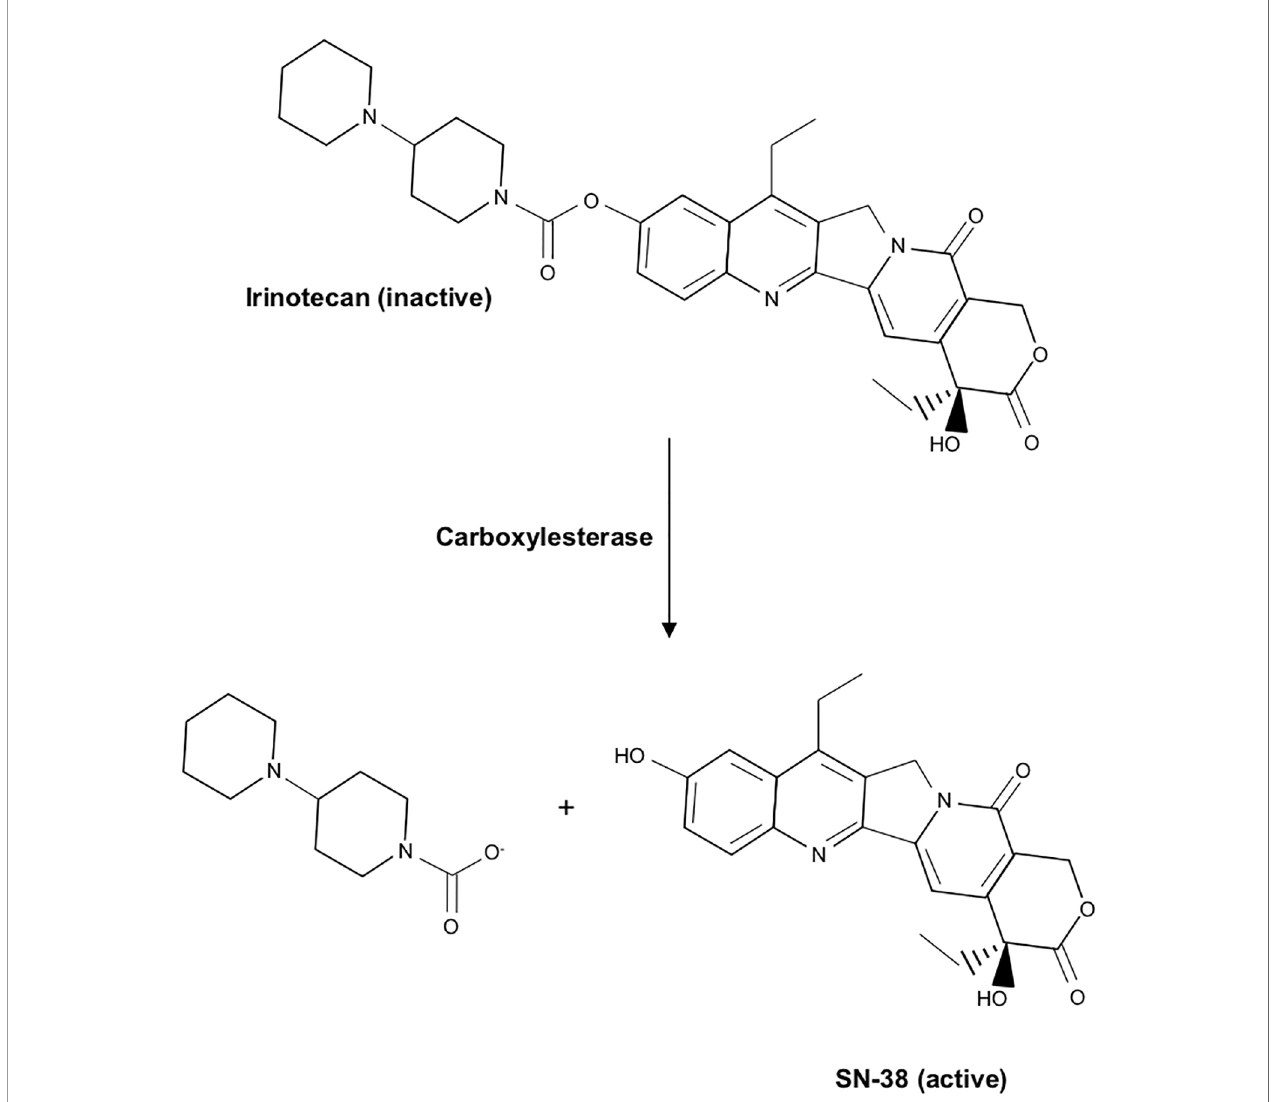
FIGURE 8 | Chemical structure of Irinotecan and conversion to its active metabolite SN-38. In the intestinal mucosa, liver, and plasma, Irinotecan undergoes carboxylesterase-mediated cleavage of the carbamate bond between the camptothecin moiety and the dipiperidino side chain, converting water-soluble Irinotecan to lipid-soluble SN-38, its active